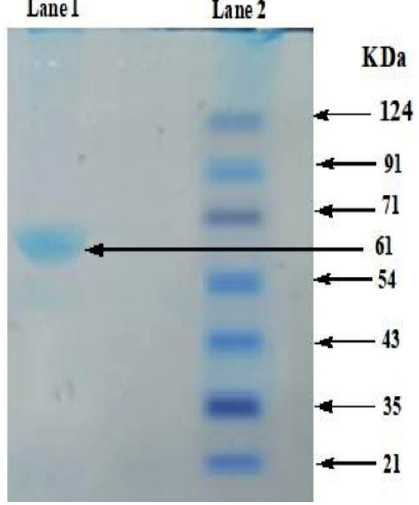
Fig. 6. SDS-PAGE of partially purified laccase from Bacillus sp. AKRC01. Lane 1: Purified laccase, Lane 2: Protein